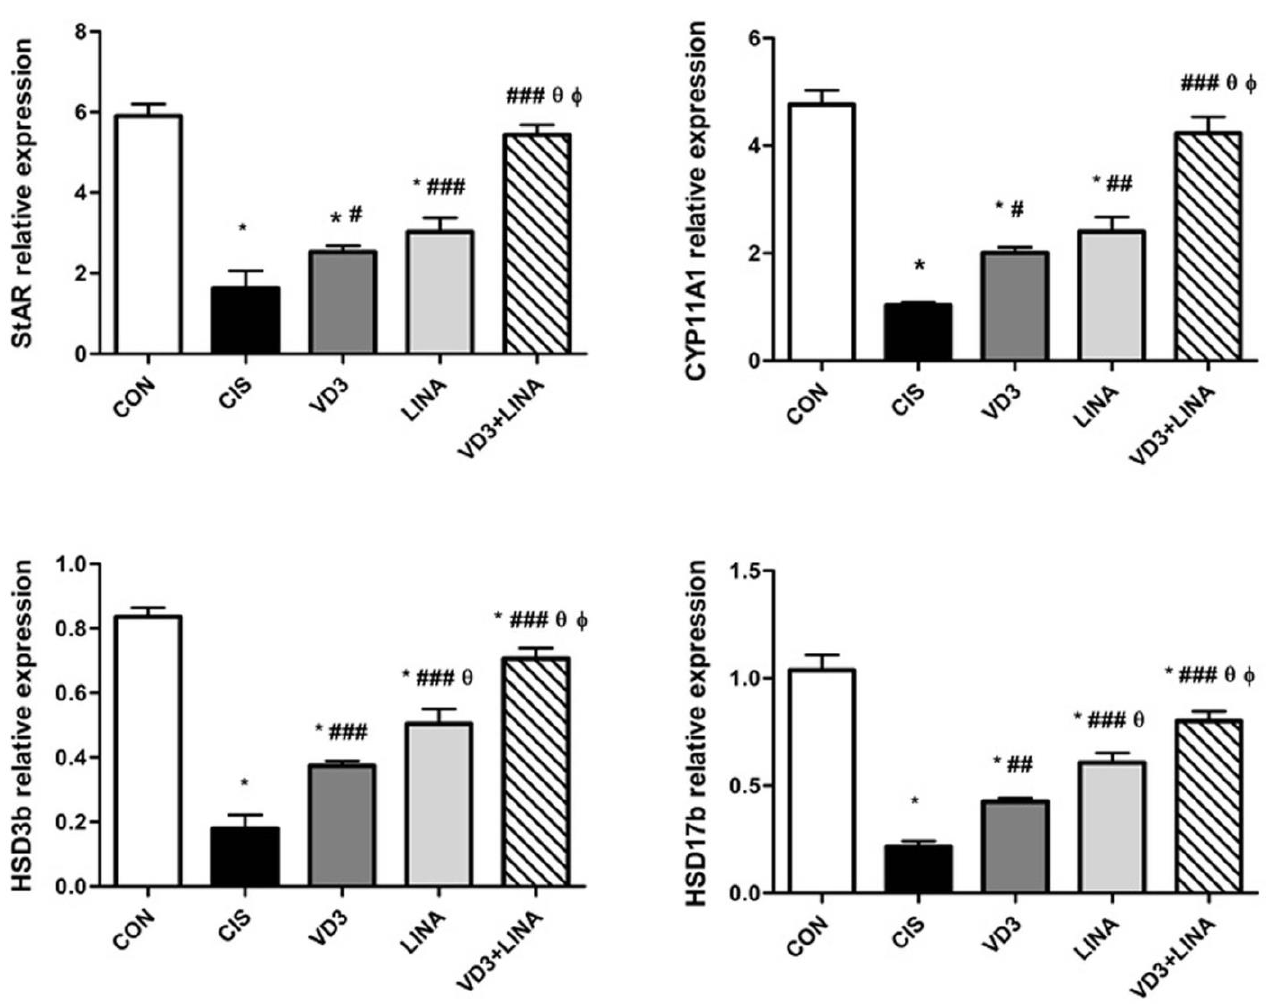
Figure 3. Effect of vitamin D3 and/or linagliptin on the relative expressions of steroidogenesis- related genes in testicular tissue of cisplatin-treated rats. Bars with error bars represent mean ± SEM ( n = 6/group); * p < 0.001 vs. CON group; # p < 0.05, ## p < 0.01, ### p < 0.001 vs. CIS group; θ p < 0.001 vs. VD3 group; φ p < 0.001 vs. LINA group. StAR: Steroidogenic acute regulatory protein; CYP11A1: cytochrome P450 family 11, subfamily A1; HSD3b: 3 beta-hydroxysteroid dehydrogenase; HSD17b: